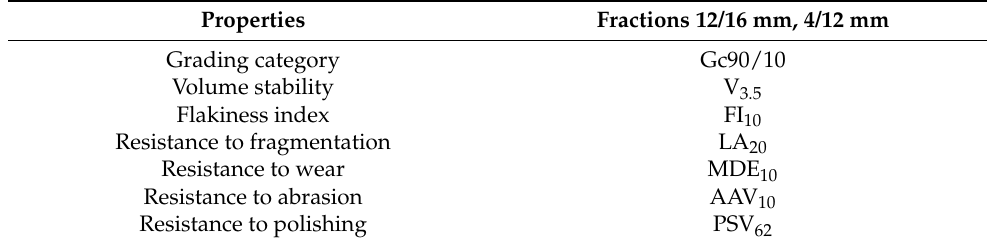
Table 1. Main properties of steel slag aggregates.